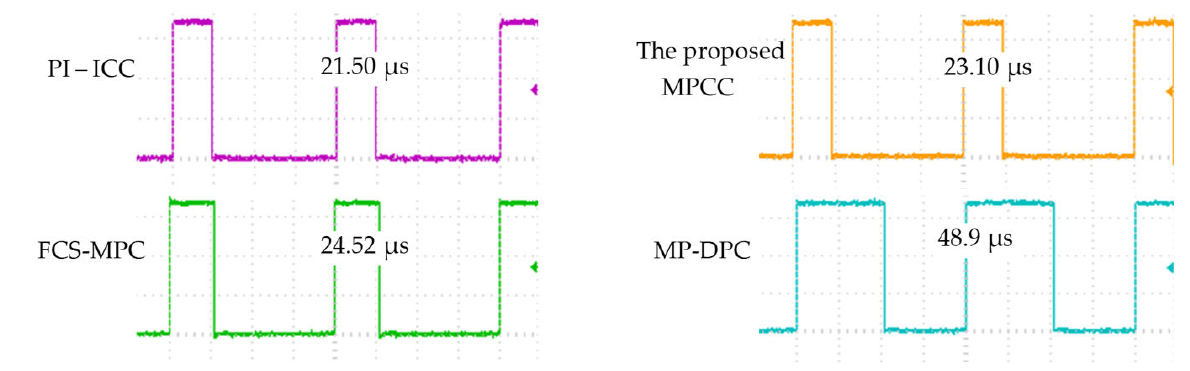
Figure 17. The execution time of these four